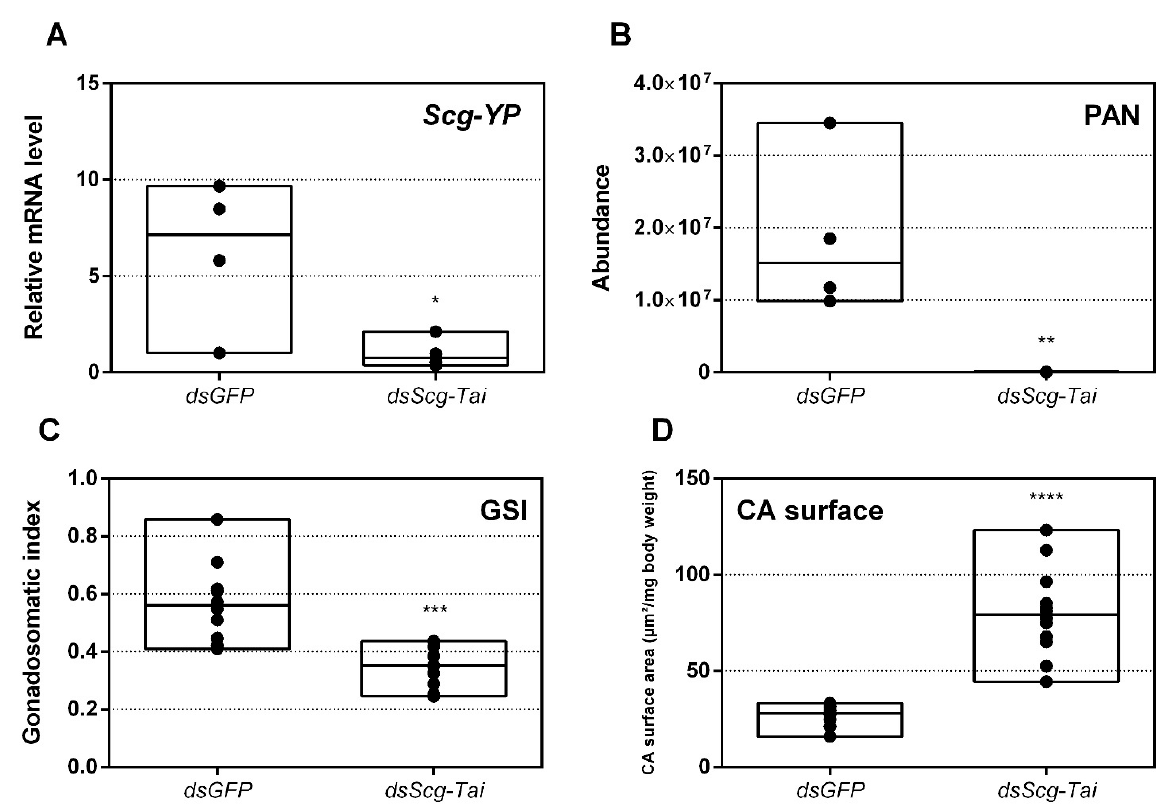
Figure 6. ( A ) Relative mRNA levels of Scg-YP measured in the epidermis of dsGFP and dsScg-Tai injected adult male desert locusts 34 days after the adult molt. Scg-YP transcript levels were significantly reduced after Scg-Tai silencing. Transcript levels in the epidermis were normalized against two reference genes, Scg-Act and Scg-Ef1a . For every condition four biological replicates, each consisting of epidermis samples from four individual locusts, were analyzed. Significant differences (Student’s T-test) are indicated with asterisks (* p < 0.05) (the statistical p-value obtained for Scg-YP was 0.0371). ( B ) Relative abundance of PAN released by dsGFP (control) and dsScg-Tai injected adult male desert locusts 26 days after the adult molt. The emission of PAN was significantly reduced when Scg-Tai was silenced. PAN emission was measured by gas chromatography–mass spectrometry (GC–MS). For every condition four individual animals were analyzed. Significant differences (Student’s T-test) are indicated with asterisks (** p < 0.01) (the statistical p-value obtained for PAN emission was 0.0018). ( C ) Gonadosomatic index (GSI) of control animals compared to dsScg-Tai treated animals. The GSI is significantly lower in dsScg-Tai treated animals compared to the control animals. This result indicates the impaired development of the testes upon silencing of Scg-Tai . For each condition 12 animals were analyzed. Significant differences (Student’s T-test) are indicated with asterisks (*** p < 0.001) (the statistical p -value obtained for GSI was 0.0001). ( D ) Normalized surface area of the CA in µ m 2 /mg body weight of dsGFP and dsScg-Tai treated animals. These data demonstrate that the CA significantly increased after dsScg-Tai treatment. For each condition 12 animals were analyzed. Significant differences (Student’s T-test) are indicated with asterisks (**** p < 0.0001). For all graphs, data points are represented in a column graph as a floating bar (min to max value) with a line indicating the median. (Abbreviations: ds = double stranded, Scg = Schistocerca gregaria , GFP = Green Fluorescent Protein, Tai = Taiman, YP = yellow protein, Act = actin, Ef1a = elongation factor